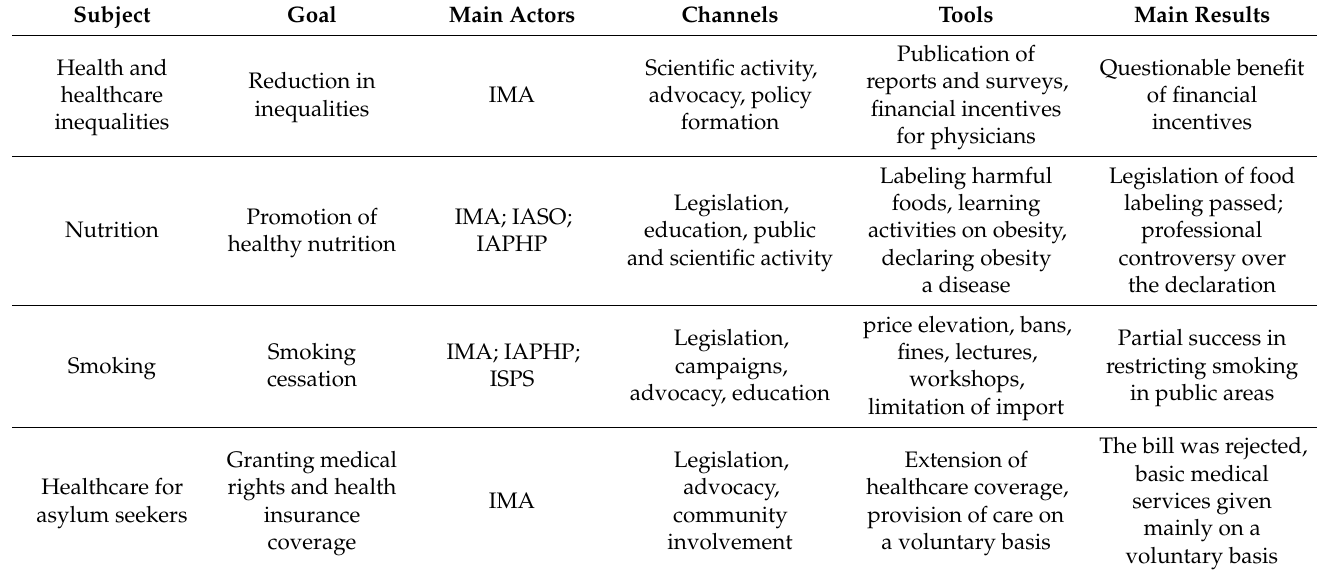
Table 2. Summary of medical associations’ activities in the public